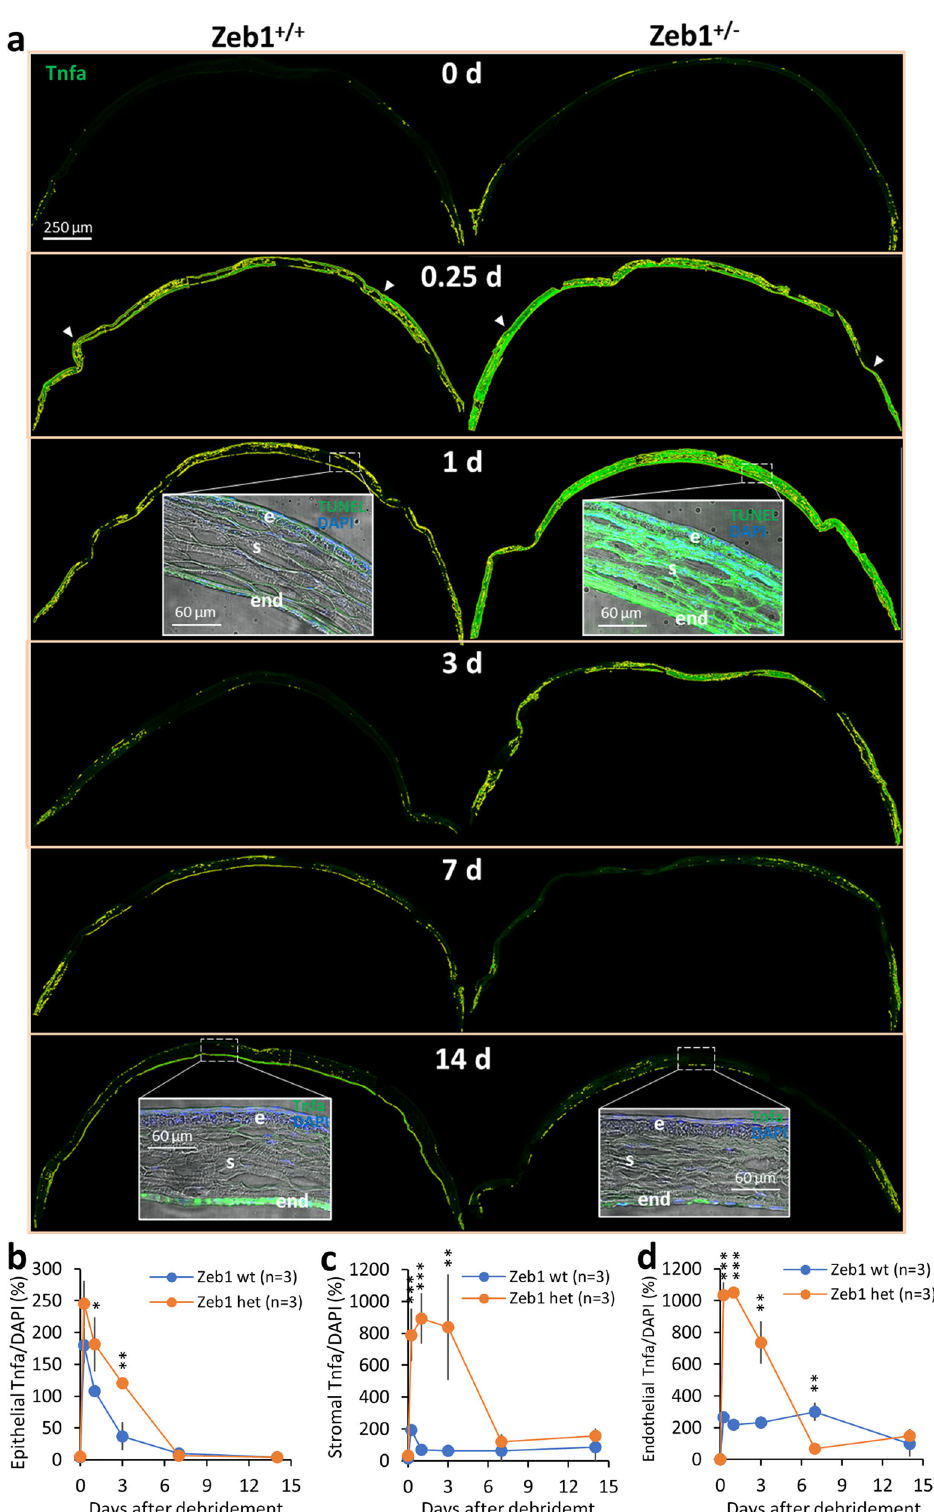
Fig. 3 Epithelial debridement increases Tnfa expression and the monoallelic Zeb1-KO enhances the debridement-induced Tnfa expression in the cornea. a Representative ImageJ-processed images of the Tnfa expression on the cryosections of Zeb1 + / + and Zeb1 + / − corneal tissues collected over period of 14 days after the epithelial debridement. The 14-day Zeb1 + / − cornea may not be representative as it was the only complete cornea while the other two corneas were broken and incomplete. The quantitative analyses on the Tnfa expression to the total DAPI + staining and the comparison between the Zeb1 + / + and Zeb1 + / − corneal tissues in b the epithelium, c the stroma, and d the endothelium. Inserts, the detailed expression of Tnfa in different corneal cellular layers after the epithelial debridement; wt, Zeb1 + / + ; het, Zeb1 + / − ; inverted white triangles, wound borders; e, the epithelium; s, the stroma; end, the endothelium. * p ≤ 0.05; ** p ≤ 0.01; *** p ≤ 0.001; n , the number of corneas used. The error bars in b , c , and d are the standard deviation (SD) bars.